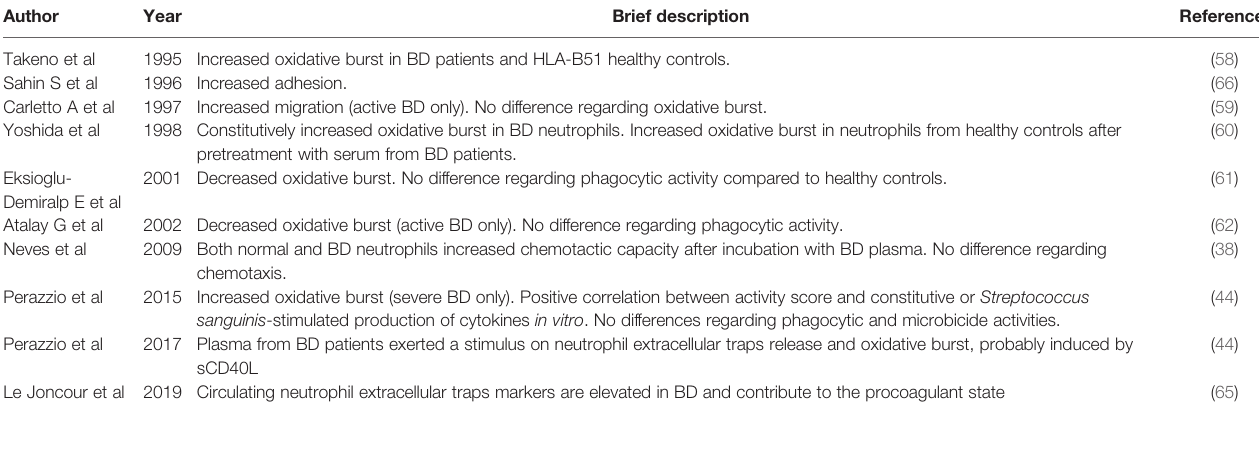
TABLE 1 | Controversies regarding phagocyte activity in Behçet ’ s disease (BD).